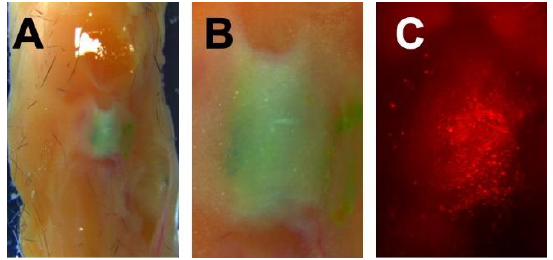
Figure 9. Representative knee joint explant from a C57BL/6 mouse that was injected with 5 μL of a 100 mg/mL suspension of particles with hydrophobic green dye IR780 (PBSe-GSK3787-IR) particles. Upon resection of the limbs, images were taken with a stereoscope to determine injectability and localization of particles. Images taken 7 days post injection of ( A ) Knee joint at 7.3× magnification; ( B ) Knee joint at 1.6× magnification; ( C ) Particles as visualized in the joint under fluorescence microscopy, 1.6× magnification.